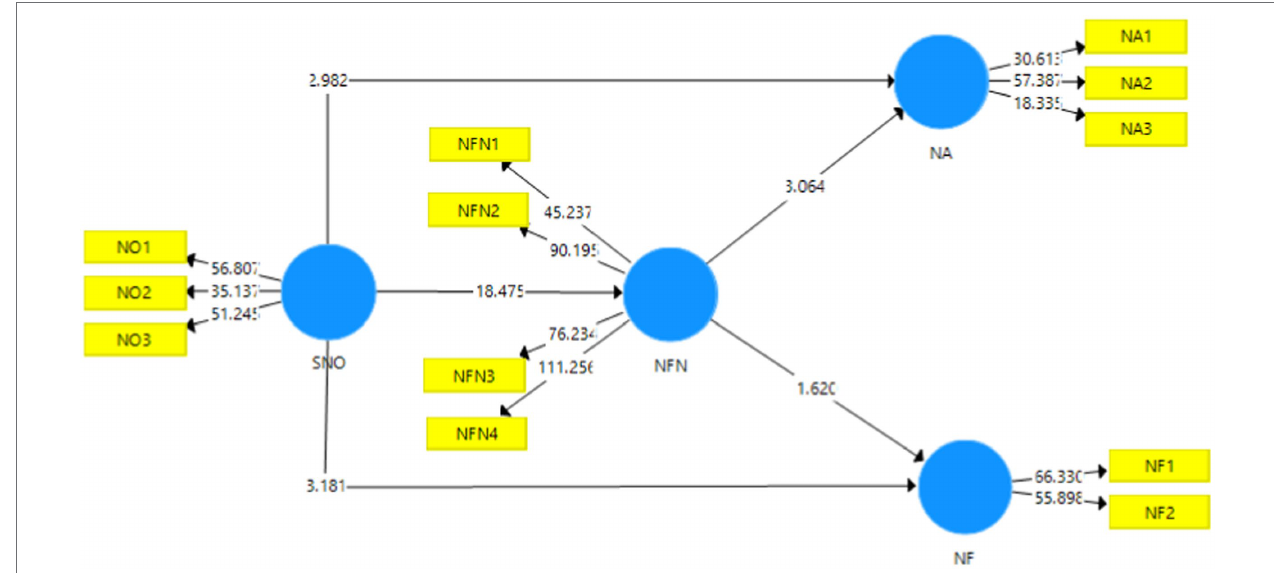
FIGURE 4 | Structural model bootstrapping without moderation. SMO, Social Media Overload; NA, News Avoidance; NF, News Filtering; NFN, Need for News.